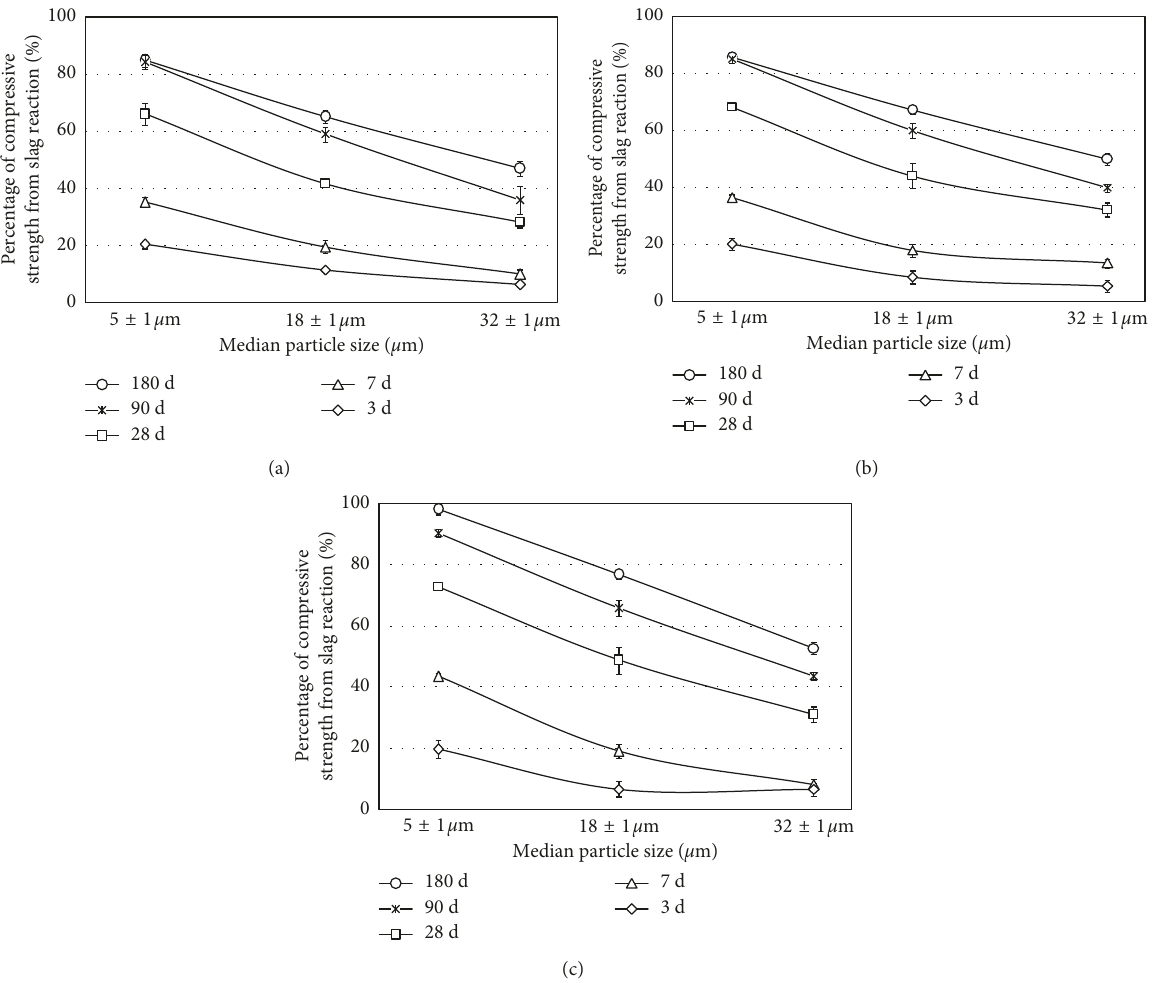
Figure 8: Relationship between percentage of compressive strength of GGBF slag mortar with different sizes (compared to PC mortar) obtained from slag reaction and age of curing: (a) 40% replacement of cement; (b) 50% replacement of cement; (c) 60% replacement of